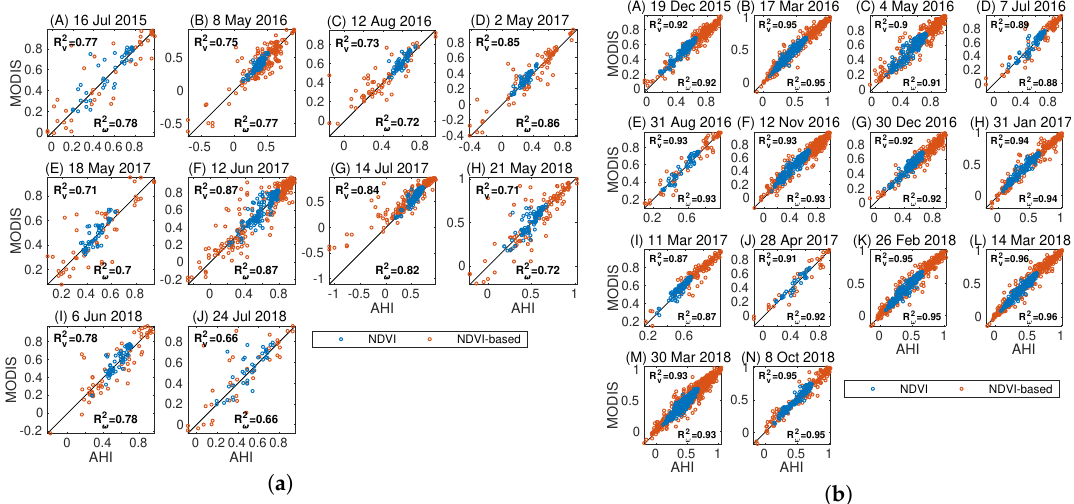
Figure 11. Scatter plots of the NDVI/NDVI-based indices calculated from the MODIS and AHI datasets; ( a ) Hokkaido, ( b ) Tokai. R 2 v is the coefficient of determination obtained from a linear regression of the AHI and MODIS NDVIs, and R 2 ω is the coefficient of determination for the NDVI-based